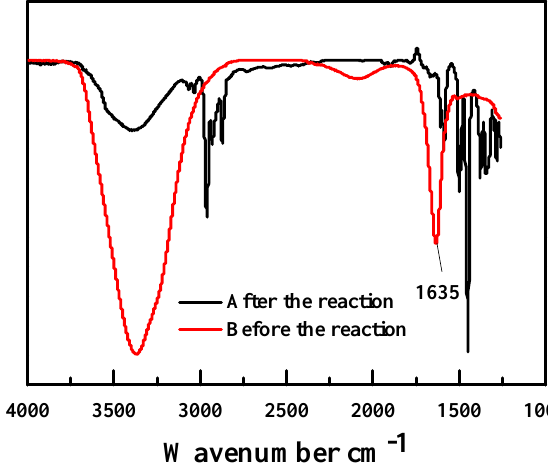
Figure 9. FTIR spectrum of the 25 mM Hf(OTf) 4 catalyst before and after the reaction.